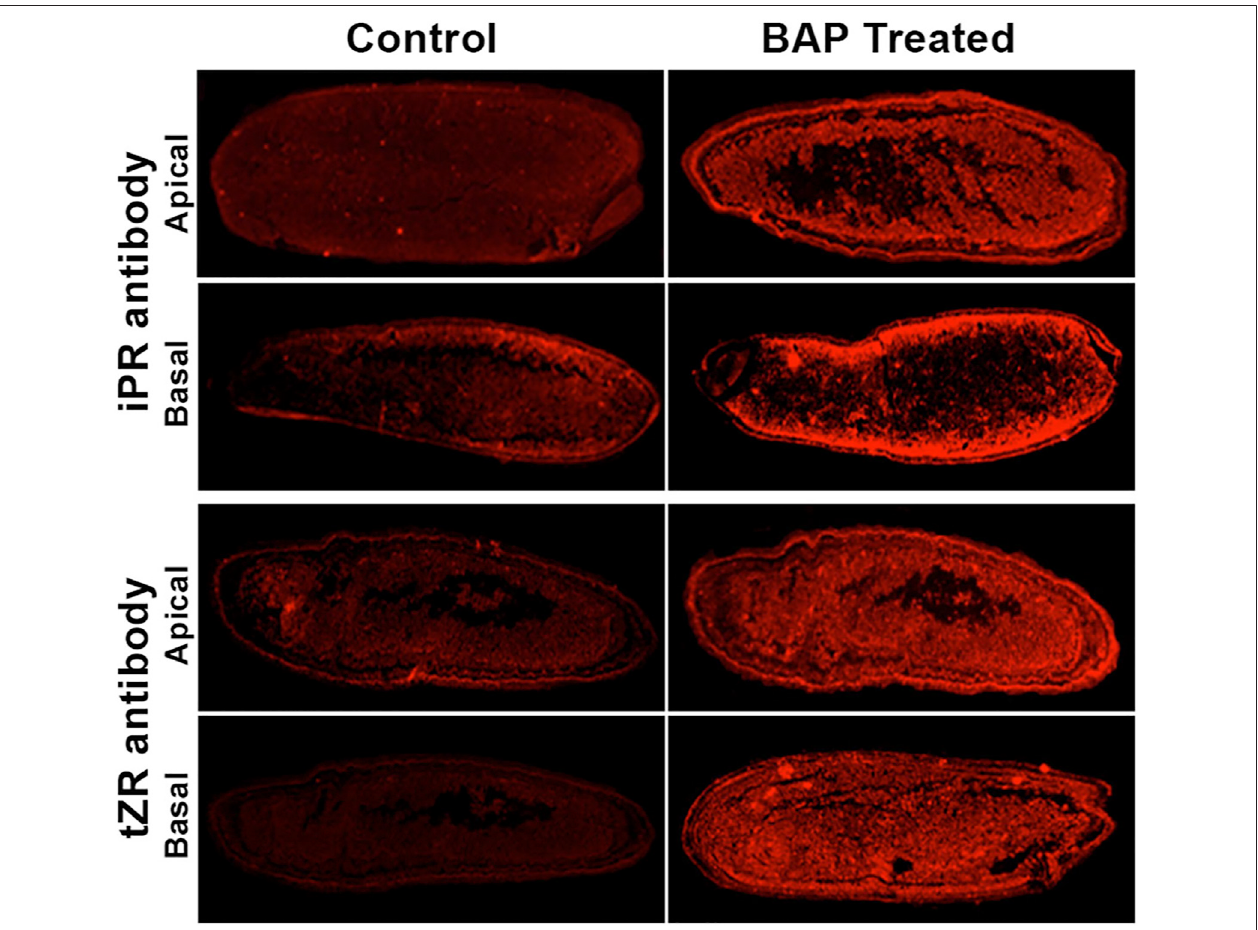
FIGURE 3 | Longitudinal sections of the caryopses sampled from the panicle of the control and that applied with 6-benzylaminopurine (BAP) and stained with the antibody against trans-zeatin riboside (tZR) and N 6 -( Δ 2 -isopentenyl)adenine (iP) riboside (iPR), the precursors of trans-zeatin and isopentenyladenine, respectively, the two cytokinins. The sections were observed under a fl uorescence stereo-microscope for the detection of the fl uorescence from these antibodies. The caryopses from the basal spikelets of the control plant emitted much lesser fl uorescence compared with that sprayed with BAP during the heading. Reproduced with the permission of the author (Panda et al.,